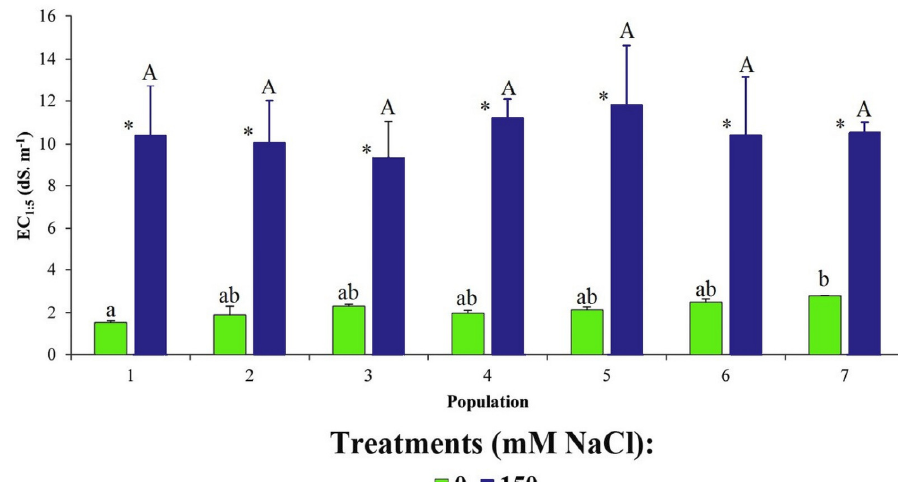
Fig. 1. Soil electric conductivity (EC ) of the pot substrates, for the seven studied populations of Romanian larch, after 30 days 1:5 of salt treatment. Values shown are means ± SE (n = 5), expressed in dS m -1 . Different letters over the bars (lower case for controls and capital letters for salt-stressed plants) indicate significant differences between different populations according to Tukey test (α = 0.05). Asterisks (*) indicate significant differences between salt and control treatments for the same population. Populations are given number codes according to Table 1